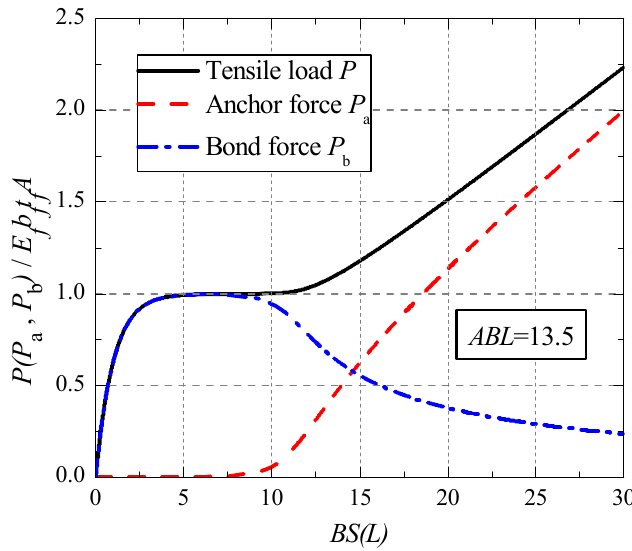
Figure 3. Relationship between P ( P a , P b ) and slip at load end.